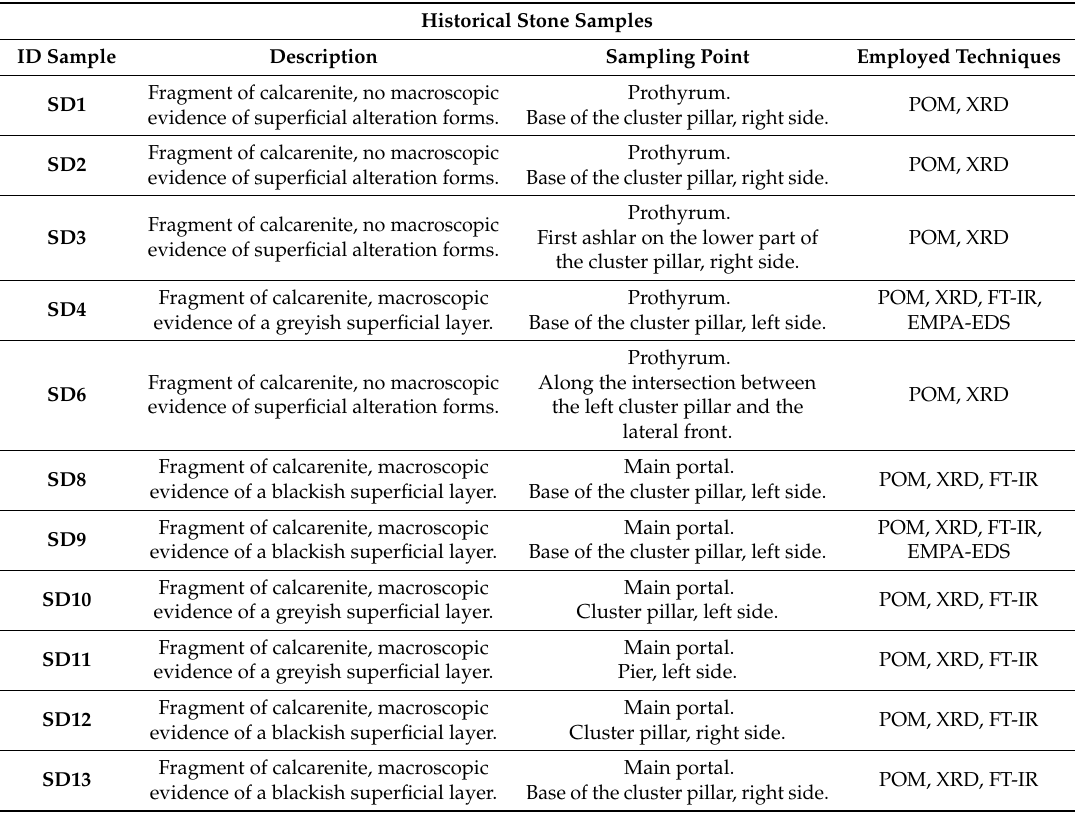
Table 1. Macroscopic features of investigated samples together with the sampling areas according to Figure 1 and employed techniques on each sample. POM = polarizing microscope; XRD = X